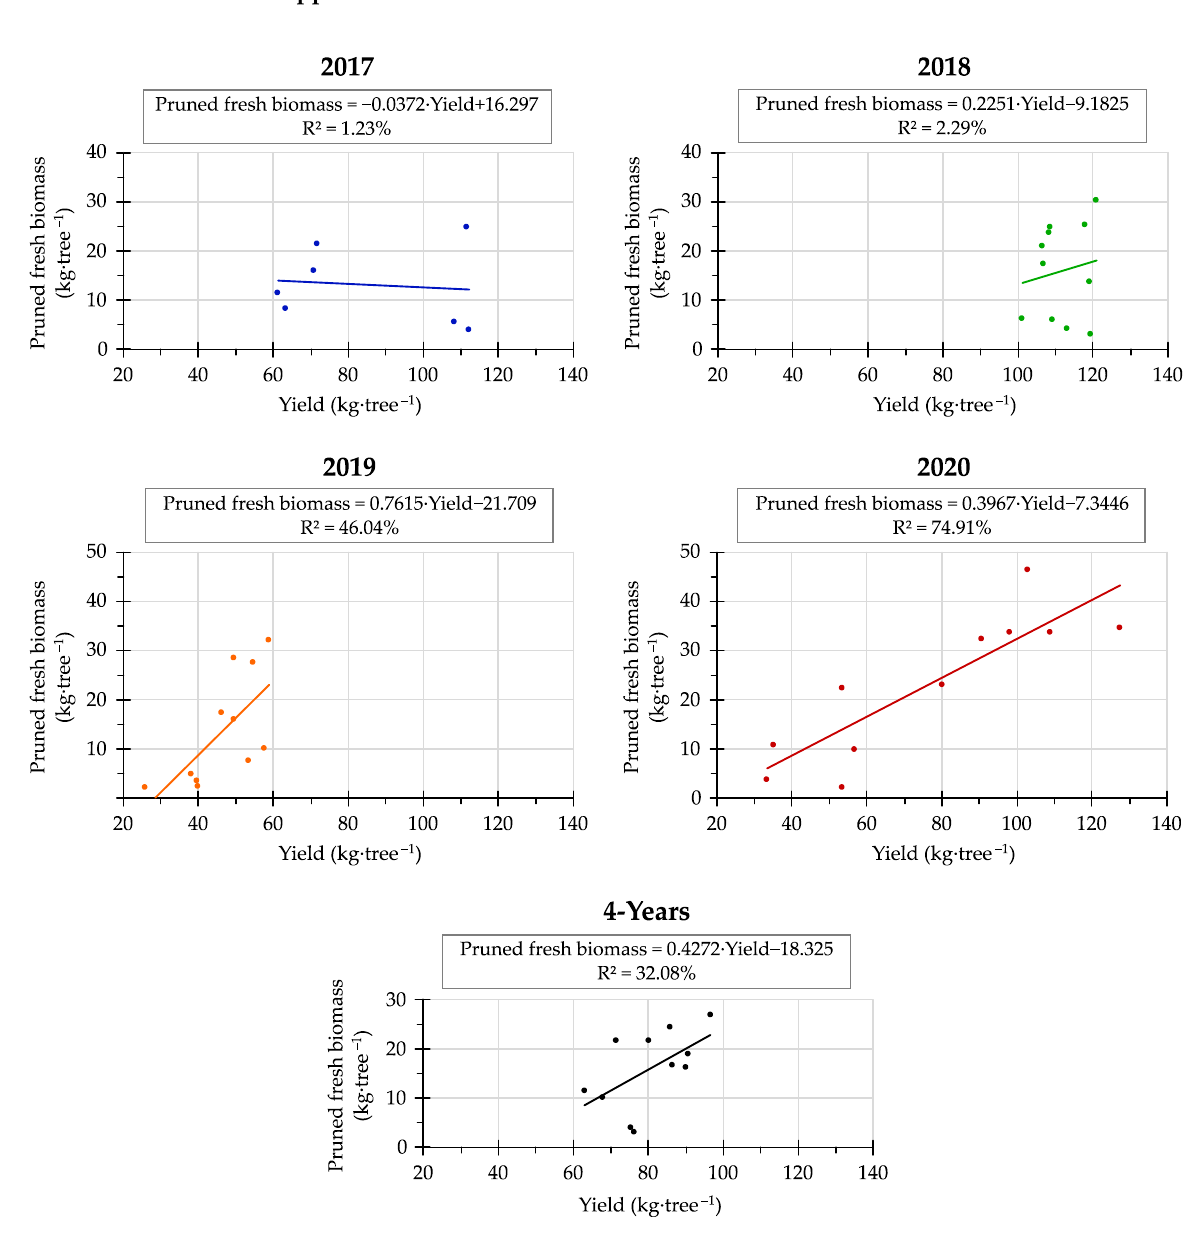
Figure A1. Pruned fresh biomass (kg · tree − 1 ) versus total yield (kg · tree − 1 ) for each pruning strategy (strategies 2–12), in each year under study (2017–2020), and for the 4-year overall. The model equations that describe the relationships between pruned fresh biomass and yield are